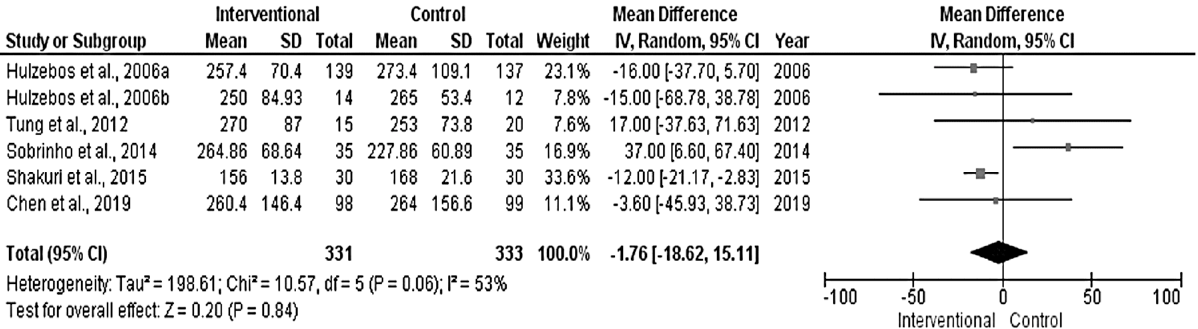
Figure 2. Forest plot evaluating surgery time in the included studies.